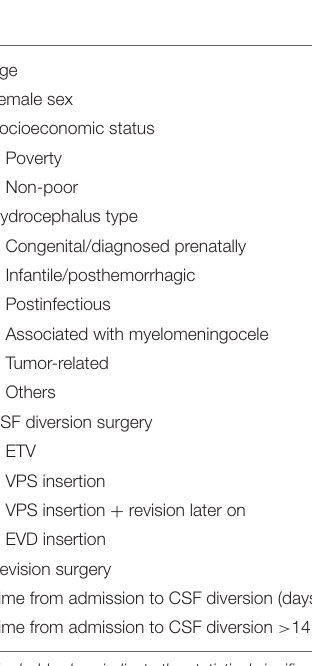
TABLE 4 | Determinants of mortality, in the subgroup from the Philippines, after binary logistic